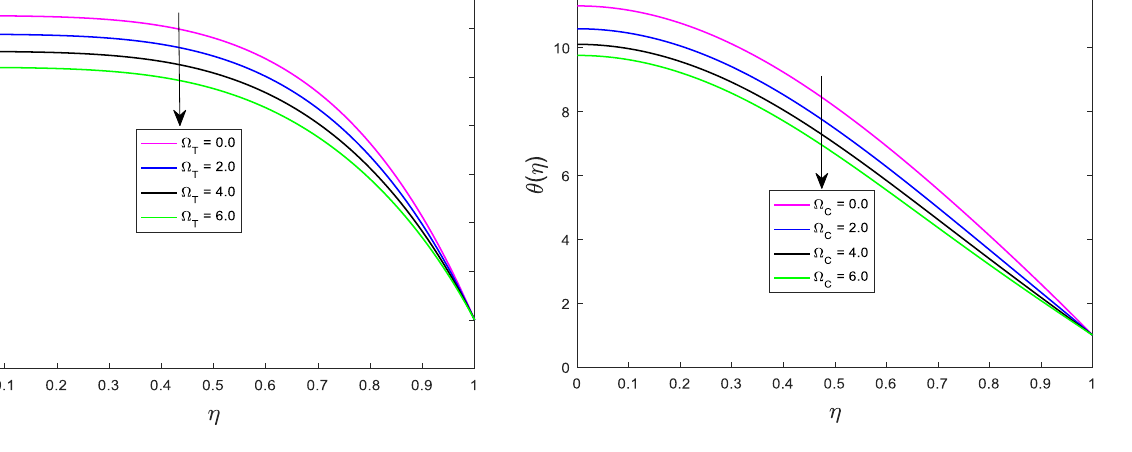
Figure 14: Effect of Ω T on θ ( η ) for fixed S = N b = Ec = 0.5, β = Ha = N t = Ω C = Kr = 0.1, Pr = 1.5 and Sc = 0.7